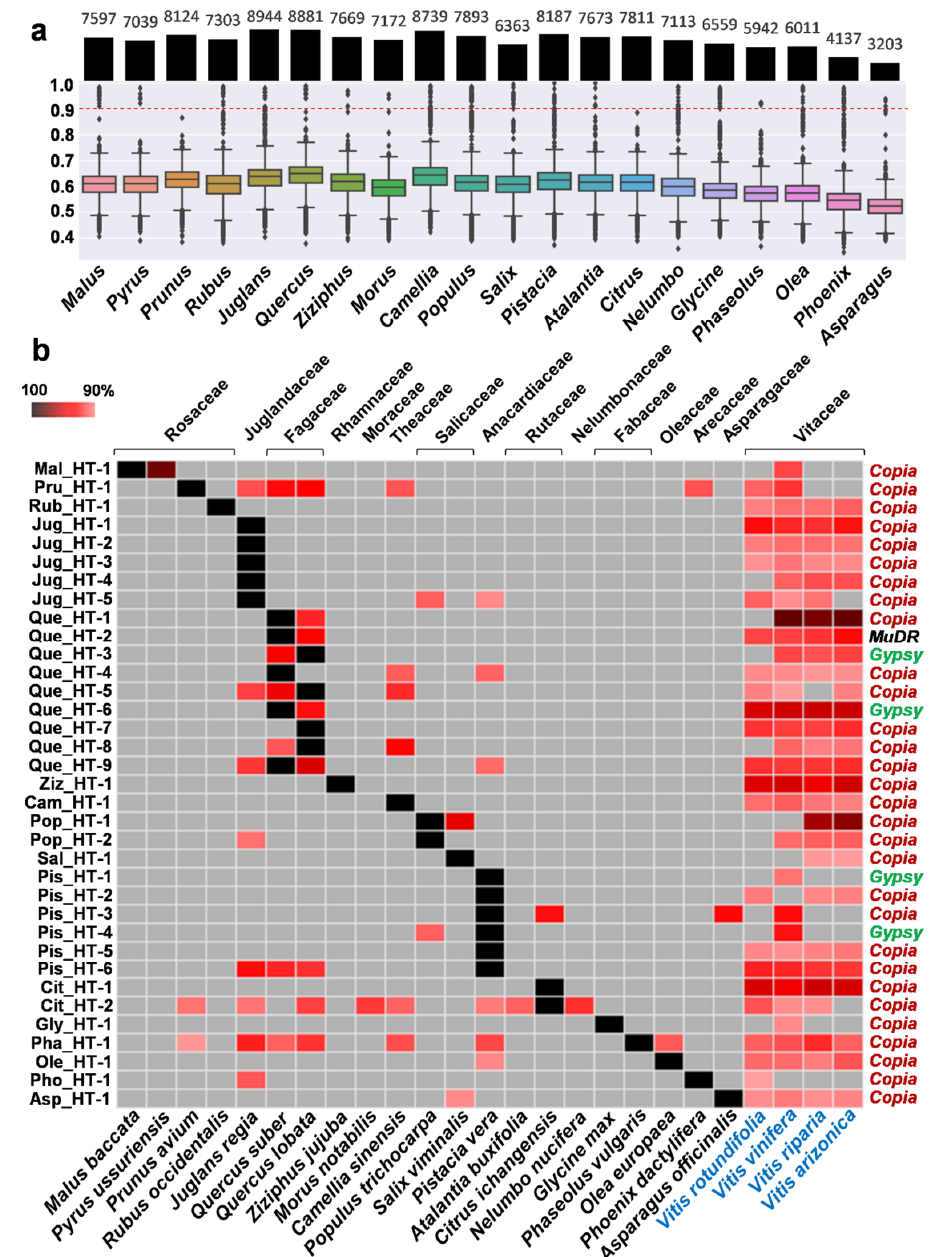
Figure 1. Identification of 35 putative HT events between four Vitis and 21 other plant species. ( a ) Box plots reveal the identity distribution of orthologous genes calculated from the 3rd codons. The number of orthologous gene sets used is presented with a bar graph on the top of the box plot panel, and the values are shown at the top of each bar. The genus names are shown at the bottom, and the range for the Y-axis is on the left side of the panel. The 90% identity threshold that was used for the HT investigation is presented by a red dotted line. ( b ) The heat map presents the sequence identity between the sequence of each HT event and that of the plant species involved in the HT. Columns and rows represent the plant species and each HT event, respectively. The names of the plant species are presented at the bottom of the panel, and those of the four Vitis species are marked with blue letters. The family names of the species are shown at the top of the panel. The names of the HT events are presented on the left side of the panel, and their classification is on the right. Two LTR retrotransposon superfamilies, Copia and Gypsy , are marked with red and green letters, respectively, and a DNA transposon, MuDR , is marked with black letters. The intensity of the red color in each box reveals identity from 90% (pale red) to 100% (black). The black box appears when the used sequence matches itself. The gray box indicates that there is no match according to the >90% identity